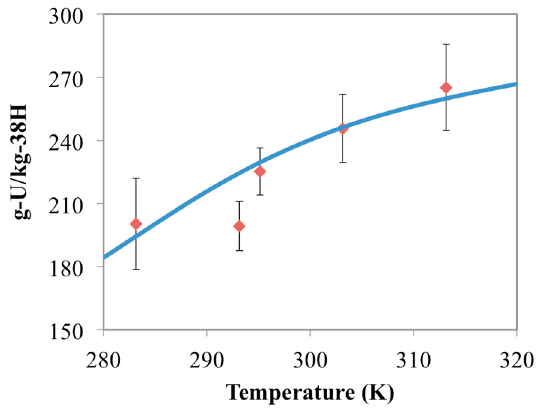
Figure 7. Comparison between chemisorption model results (blue line) and the 38H experimental data (red diamonds) collected in this study. Error bars represent two standard deviations of the data.